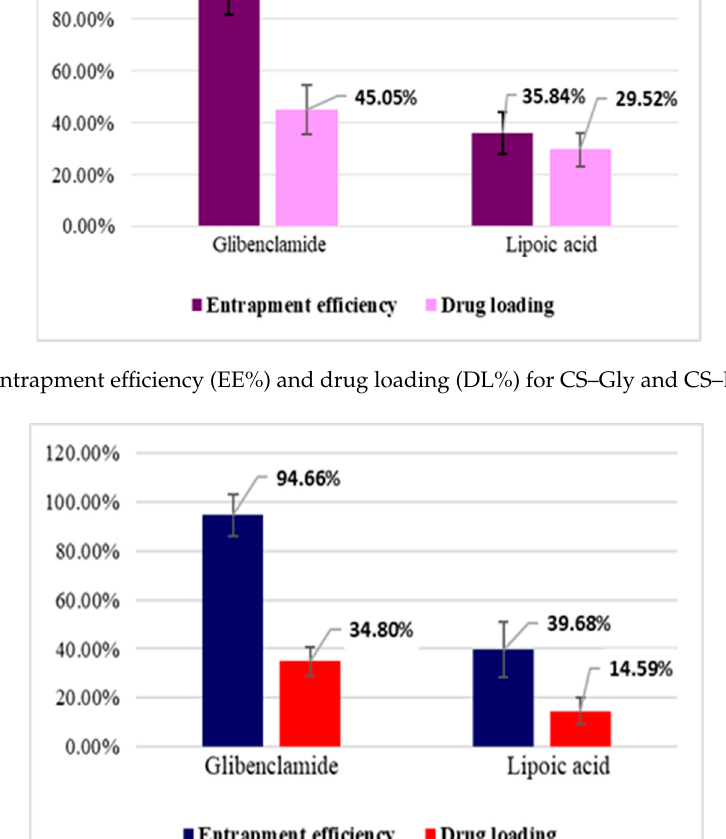
Figure 6. Swelling degree (%) in distilled water.